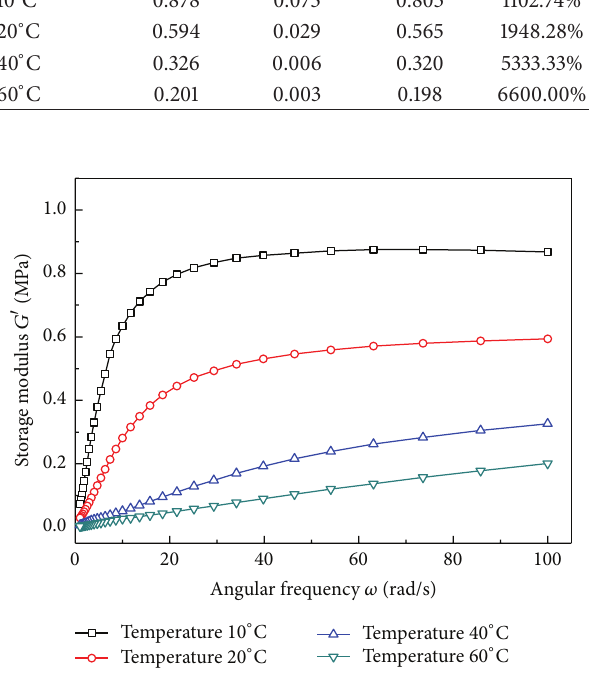
Figure 5: The effect of temperature on shear stiffening property for